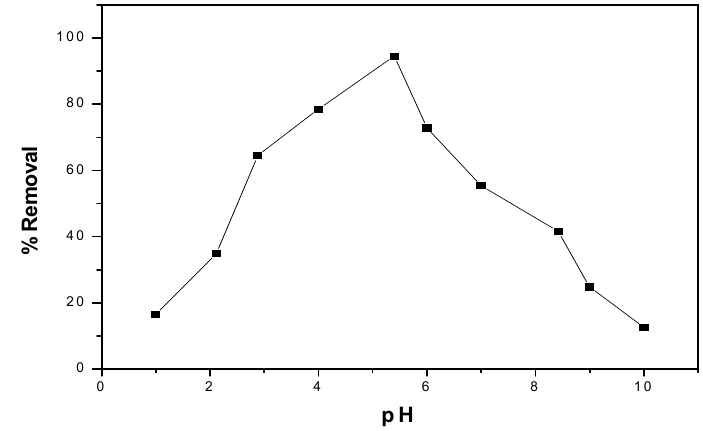
Fig.8. Effects of pH on Pb(II) ions